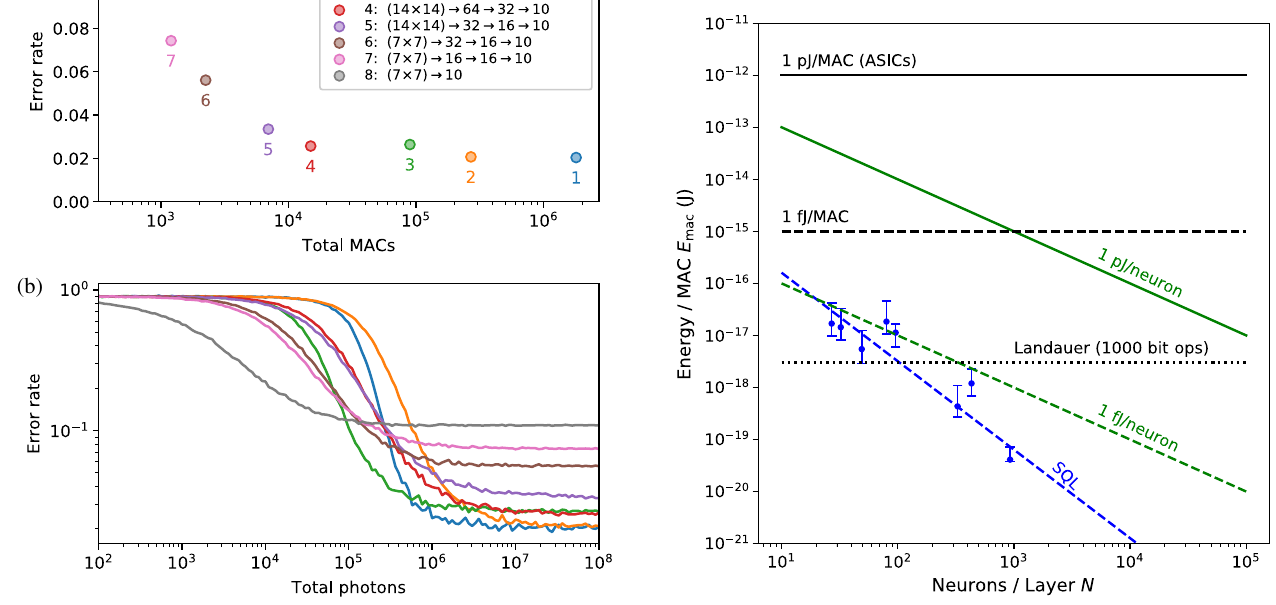
ð E Þ ¼ err MAC